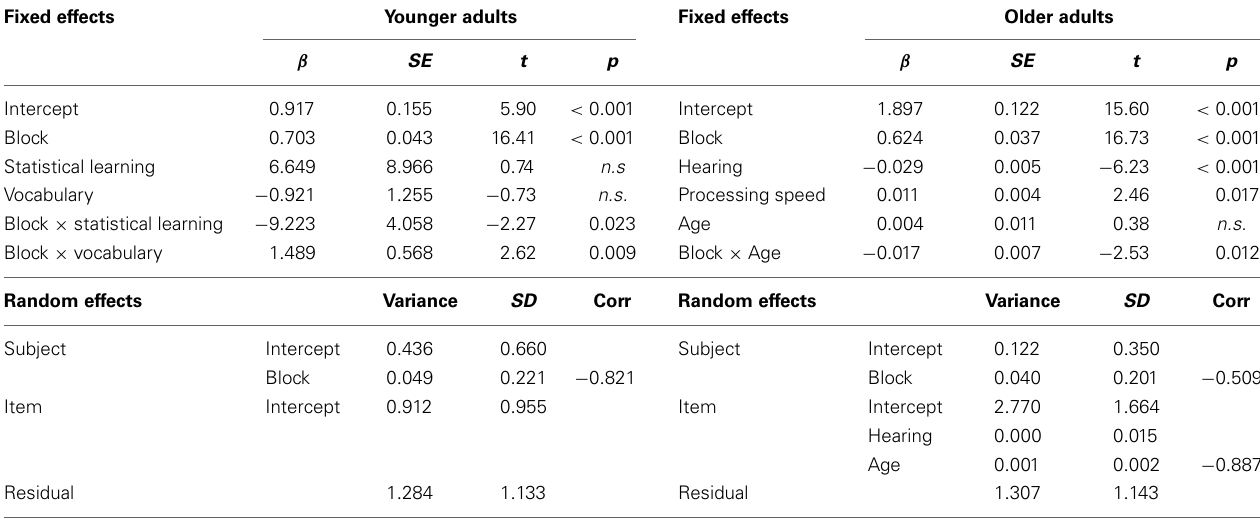
Table 5 | Statistical models for sentence identification performance of younger and older adults in the perceptual learning task. Fixed